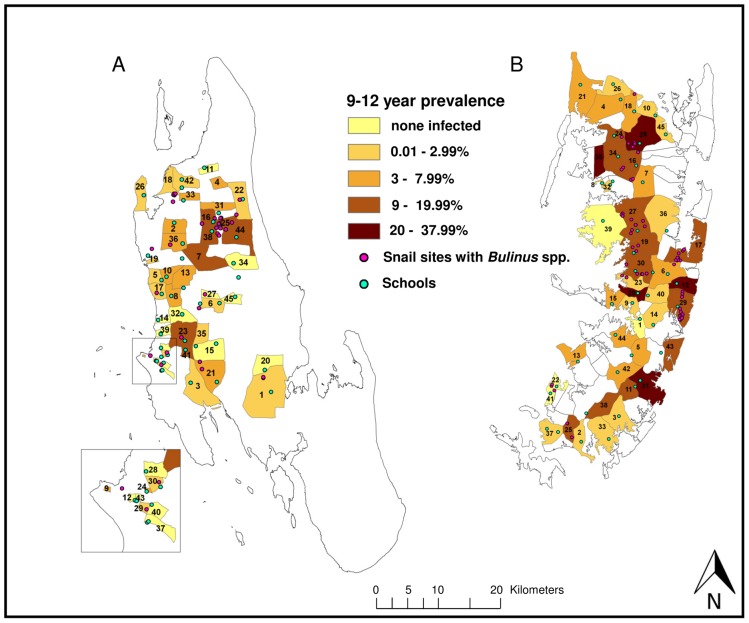

S. haematobium prevalence in 9–12-year-old school children in 45 study shehias in Unguja (A) and Pemba (B).Map indicating the S. haematobium prevalence in 9- to 12-year school children in the 45 study shehias in Unguja (A) and Pemba (B) at the baseline survey conducted in January-March 2012, surveyed schools in all 45 study shehias per island and sites in the 15 snail control shehias per island, where Bulinus spp. snails were found. Shehias in Unguja and their assigned intervention: Biannual mass drug administration with praziquantel: 1 = Cheju, 2 = Donge Mnyimbi, 3 = Fuoni Kibondeni, 4 = Gamba, 5 = Kama, 6 = Kiboje Mkwajuni, 7 = Kitope, 8 = Mbuzini, 9 = Mchangani, 10 = Mfenesini, 11 = Mkwajuni, 12 = Muungano, 13 = Mwakaje, 14 = Mwanyanya, 15 = Ubago; biannual mass drug administration with praziquantel plus snail control: 16 = Bandamaji, 17 = Chuini, 18 = Donge Mchangani, 19 = Fujoni, 20 = Jendele, 21 = Jumbi, 22 = Kandwi, 23 = Kianga, 24 = Kilimahewa Juu, 25 = Kinyasini, 26 = Mafufuni, 27 = Miwani, 28 = Mtopepo, 29 = Nyerere, 30 = Welezo; biannual mass drug administration with praziquantel plus behaviour change interventions: 31 = Chaani Kubwa, 32 = Dole, 33 = Donge Mtambile, 34 = Kilombero, 35 = Koani, 36 = Mahonda, 37 = Melinne, 38 = Mgambo, 39 = Mtoni, 40 = Mwanakwerekwe, 41 = Mwera, 42 = Pale, 43 = Sebleni, 44 = Upenja, 45 = Uzini. Shehias in Pemba and their assigned intervention: Biannual mass drug administration with praziquantel: 1 = Chanjaani, 2 = Kangani, 3 = Kiwani, 4 = Konde, 5 = Matale, 6 = Ole, 7 = Pandani, 8 = Selemu, 9 = Tibirinzi, 10 = Tumbe, 11 = Ukutini, 12 = Uwandani, 13 = Wambaa, 14 = Wawi, 15 = Wesha; Biannual mass drug administration with praziquantel plus snail control: 16 = Finya,17 = Kangagani, 18 = Kinowe, 19 = Kisiwani, 20 = Kwale, 21 = Makangale, 22 = Makombeni, 23 = Mbuzini, 24 = Mgogoni, 25 = Mkanyageni, 26 = Msuka, 27 = Piki, 28 = Shumba Viamboni, 29 = Vitongoji, 30 = Ziwani; biannual mass drug administration with praziquantel plus behaviour change interventions: 31 = Chambani, 32 = Jadida, 33 = Kengeja, 34 = Kinyasini, 35 = Kizimbani, 36 = Mchangamdogo, 37 = Michenzani, 38 = Mtambile, 39 = Mtambwe Kusini, 40 = Ng'ambwa, 41 = Ng'ombeni, 42 = Ngwachani, 43 = Pujini, 44 = Shungi, 45 = Sizini.